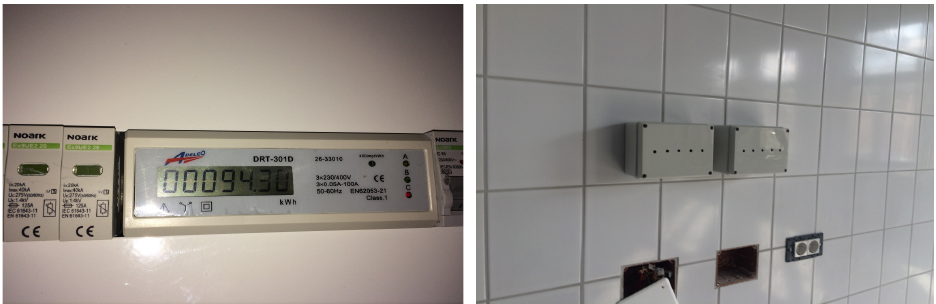
Fig. 10. Monitoring system plan Fig. 15. Mechanical room flow meters Fig. 16. Ventilation sensors